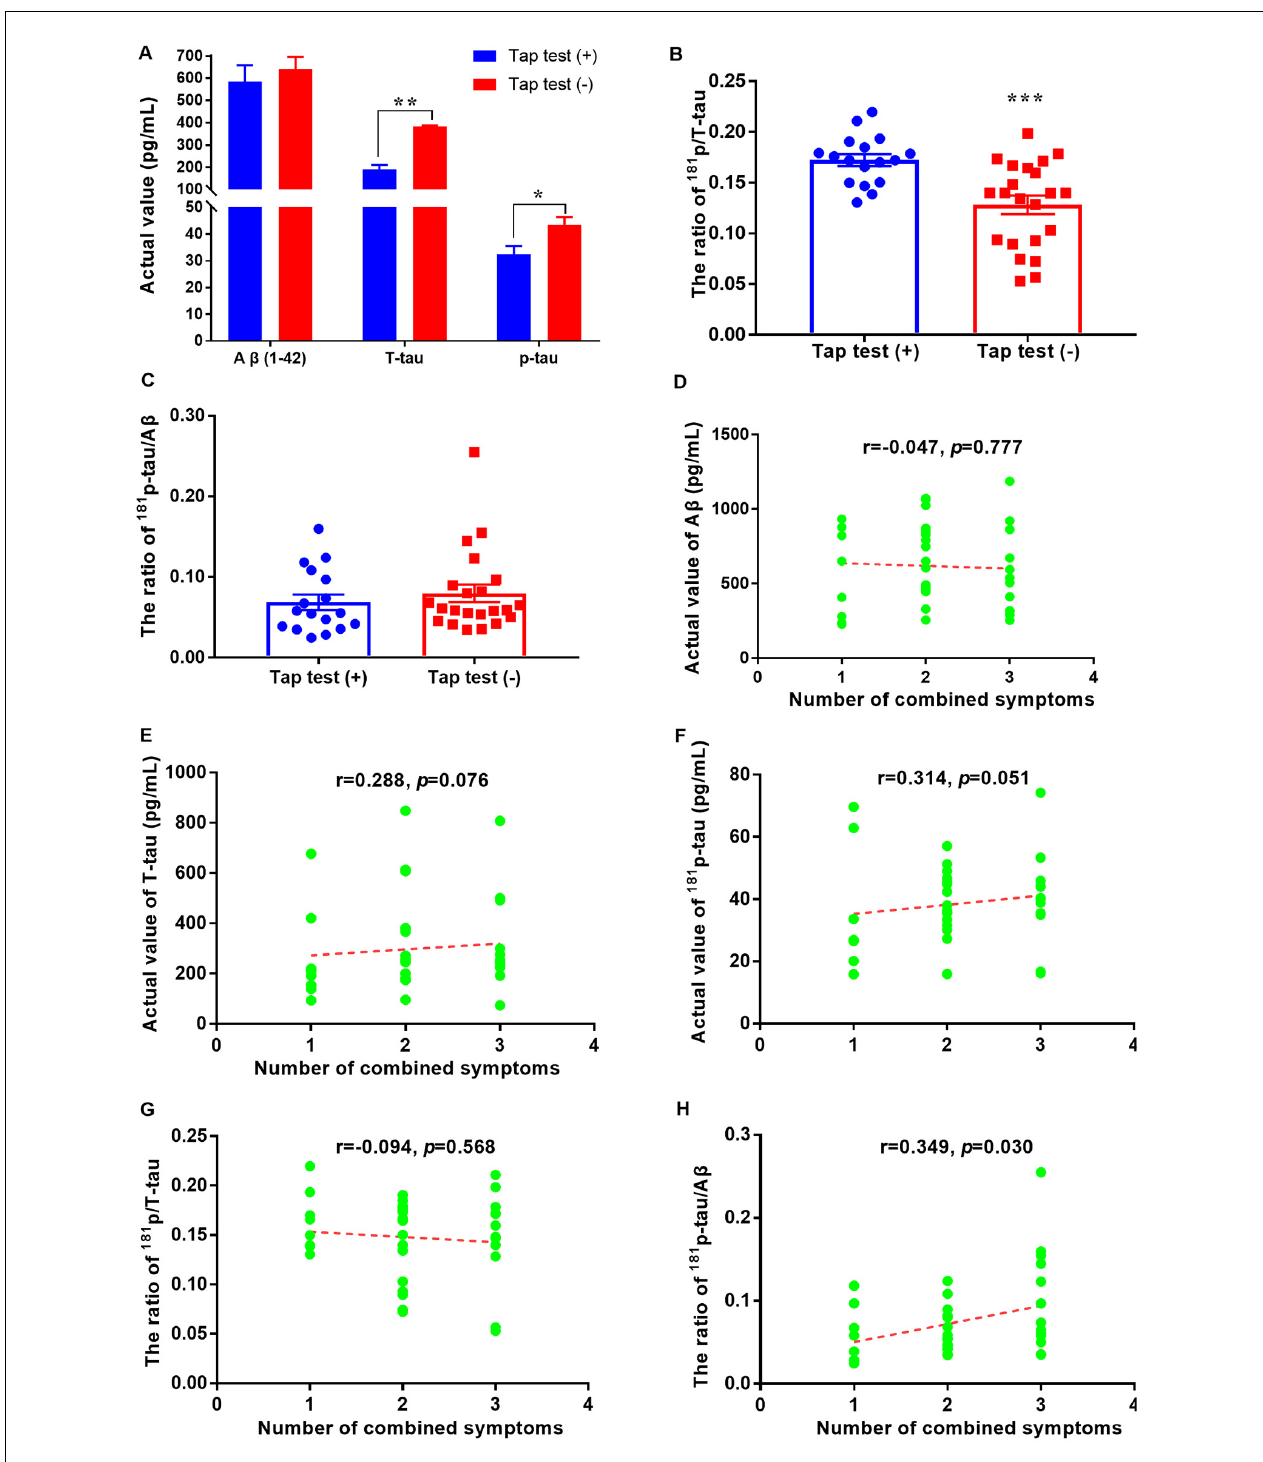
FIGURE 2 | A β 1–42 and tau levels and their relationships with tap test responsiveness or combined symptoms in patients with iNPH. (A) Comparison of CSF levels of A β 1–42, T -tau, and p -tau between the tap test (+) and ( − ) groups (* p < 0.05 and ** p < 0.01 compared with the corresponding group). (B) Comparison of the ratio of 181 p/ T -tau in the tap test (+) and ( − ) groups (*** p < 0.001 compared with the corresponding group). (C) Comparison of the ratio of 181 p -tau/A β 1–42 between the tap test (+) and ( − ) groups. (D–H) Correlation analyses between the actual levels of A β 1–42, T -tau, p -tau, p/ T -tau, and p -tau/A β 1–42 with the numbers of combined